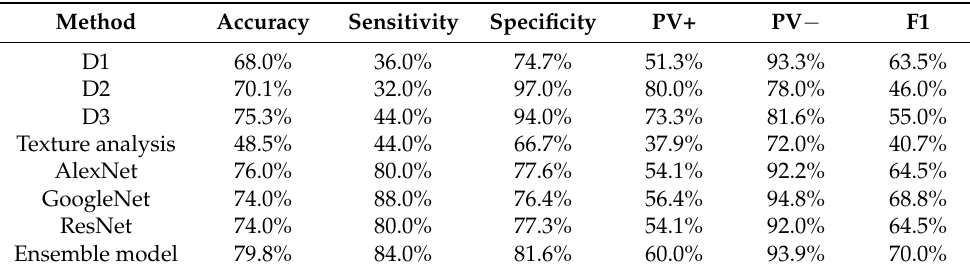
Table 2. Performances of the three dermatologists (D1, D2, D3) on test set 1 and automated algorithms (texture analysis, AlexNet, GoogleNet, ResNet, ensemble model).